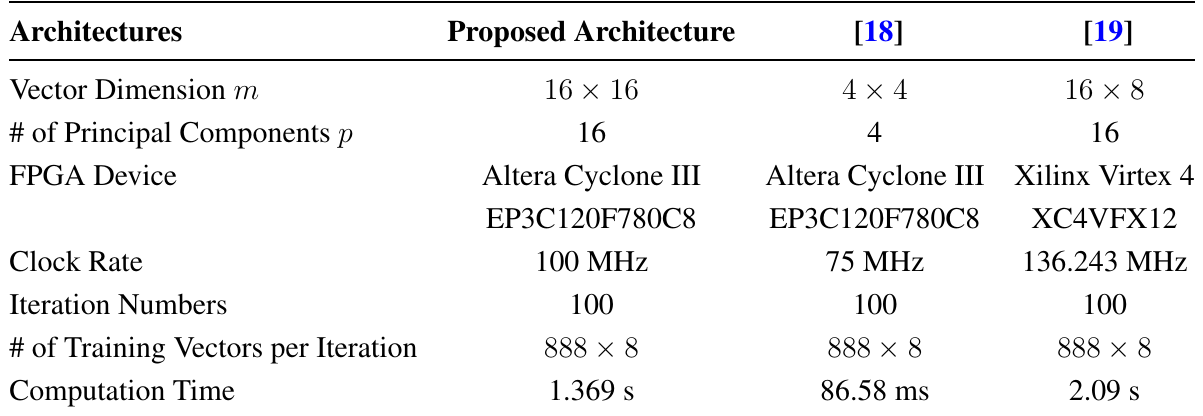
Table 5. Computation Time of Various GHA